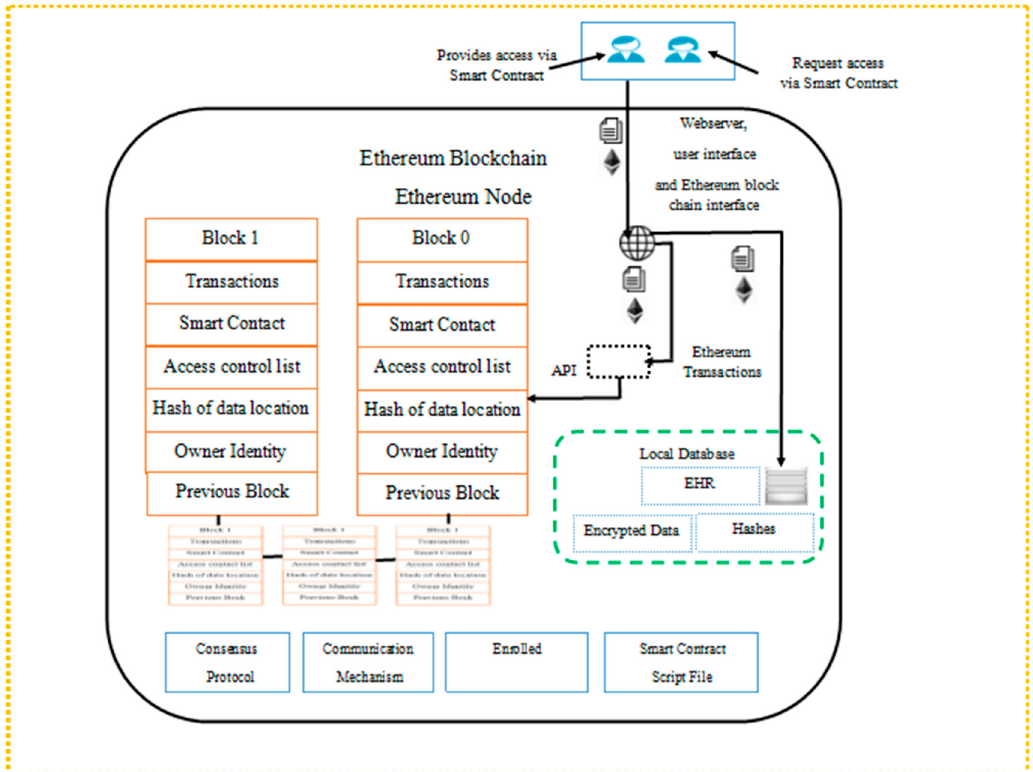
Figure 2. System workflow with smart contract controlled access.